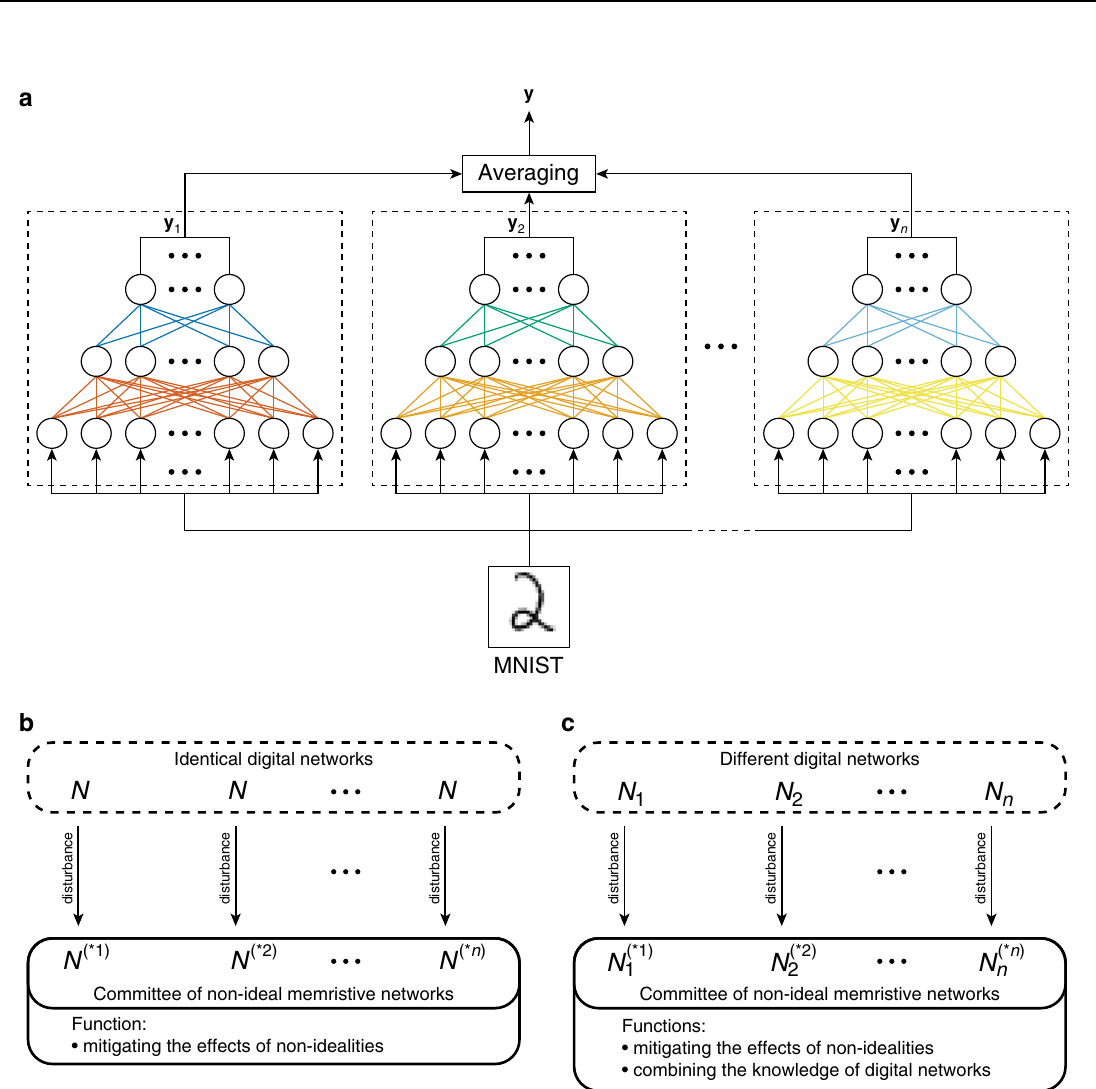
Fig. 1 Using multiple neural networks to improve inference accuracy. a The principle of ensemble averaging. b Using identical digital networks when implementing committees of memristive neural networks only helps to deal with the damage to the networks caused by the non-idealities. c Using different digital networks when implementing committees of memristive neural networks both helps to deal with the damage to the networks caused by the non- idealities and allows to combine the knowledge about the dataset acquired by individual digital